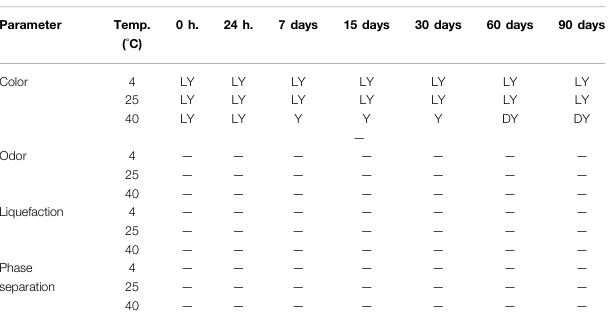
LY (cid:2) Light yellow; Y (cid:2) Yellow; DY (cid:2) Dark yellow; — (cid:2) No change.